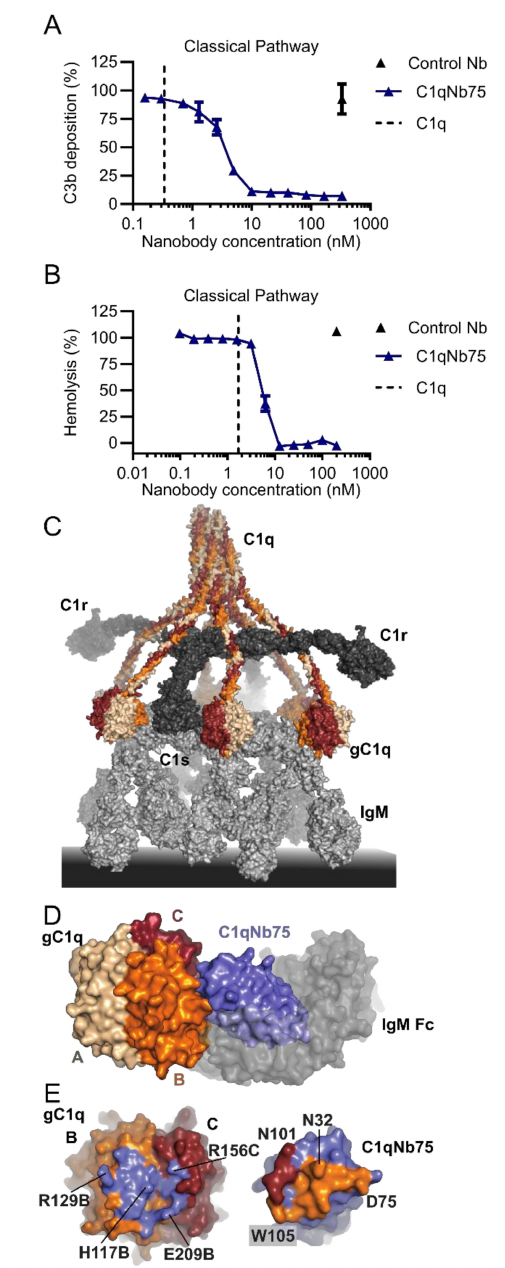
Figure 3. Structure and function C1qNb75. ( A ) Effect of C1qNb75 or control nanobody (Nb) on C3 fragment deposition in 0.2% NHS. The CP was activated by heat aggregated IgG. ( B ) Hemolysis of IgM coated sheep erythrocytes in the presence of C1qNb75 or control Nb in 1% NHS. The putative C1q concentration in the assay is shown as a dashed line. ( C ) Structural model of the C1 complex bound to IgM based on [12]. The three chains of C1q is shown in wheat, orange and dark red. C1r and C1s in dark grey and IgM in light grey. ( D ) Structure of the globular domain of C1q (gC1q) in complex with C1qNb75 (blue) (protein data bank (PDB) entry 6Z6V). IgM-Fc (semi-transparent grey surface) is shown to illustrate the steric clash between C1qNb75 and IgM. Adapted from (man). ( E ) Epitope of C1qNb75 (left) on gC1q shown in blue and paratope on C1qNb75 (right). The paratope on C1qNb75 is colored according to the C1q chain